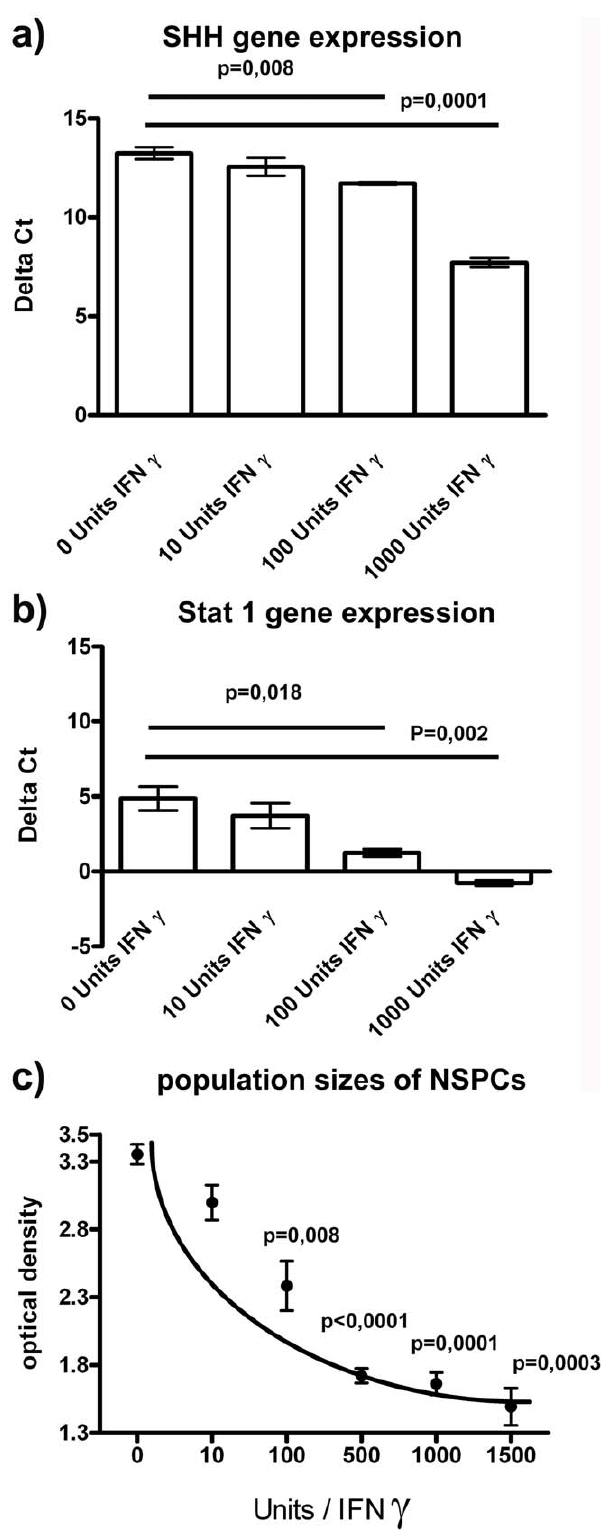
Figure 2. The effects of IFN c treatment in NSPCs are dose- dependent. In Figure 2 a, b, c: Gene expression of SHH and Stat 1 or the population sizes of the NSPCs are shown in relation to illustrated concentrations of IFN c . Values are means + / 2 standard error of mean (SEM). Independent experiments were repeated for three times in